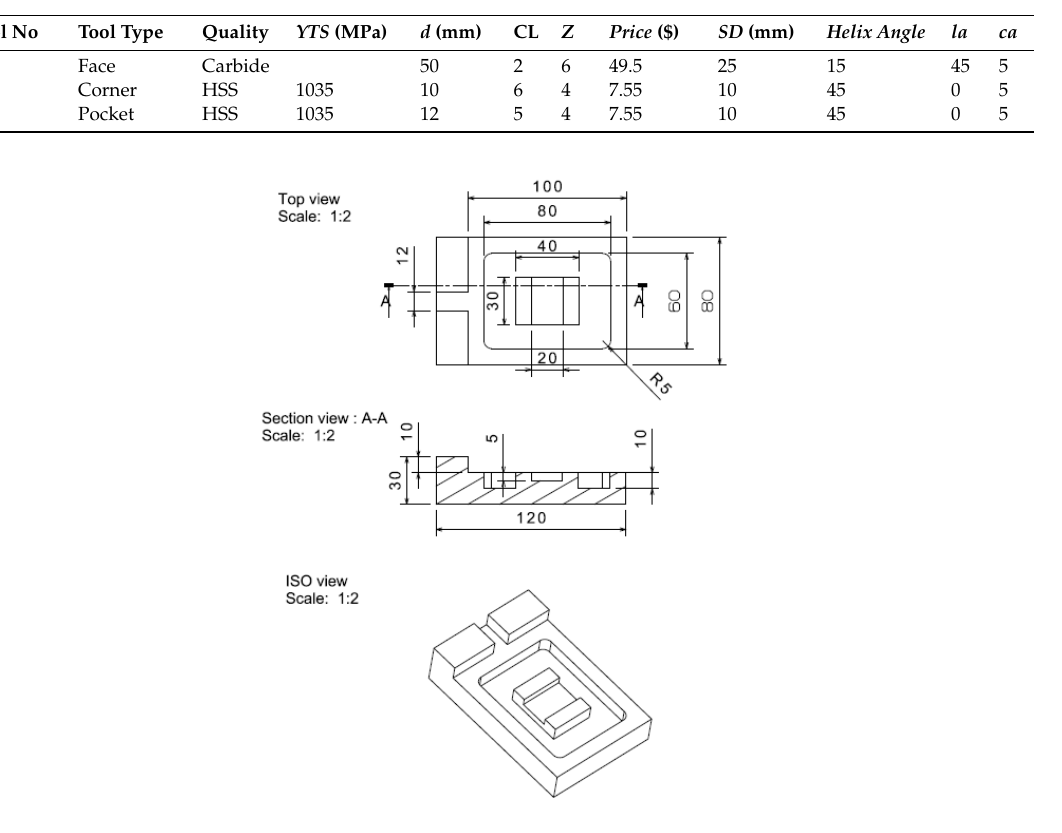
Figure 4. Case study drawing [7].